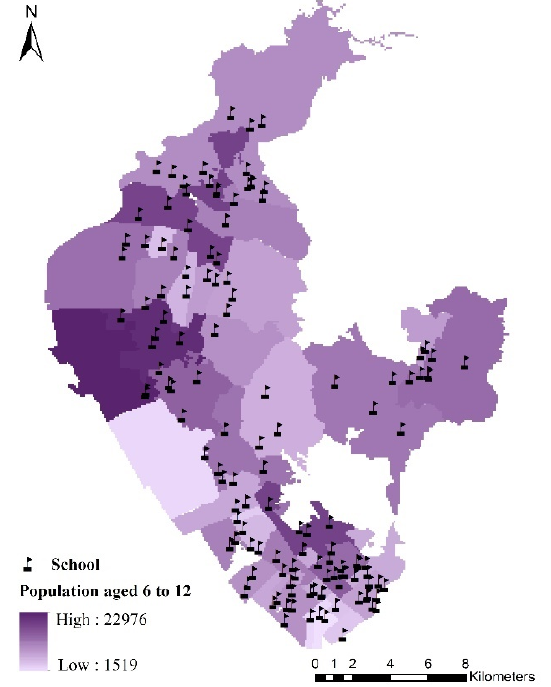
Figure 3. Distribution of elementary schools and the school-age population in the existing school districts in the Bao’an District, Shenzhen.